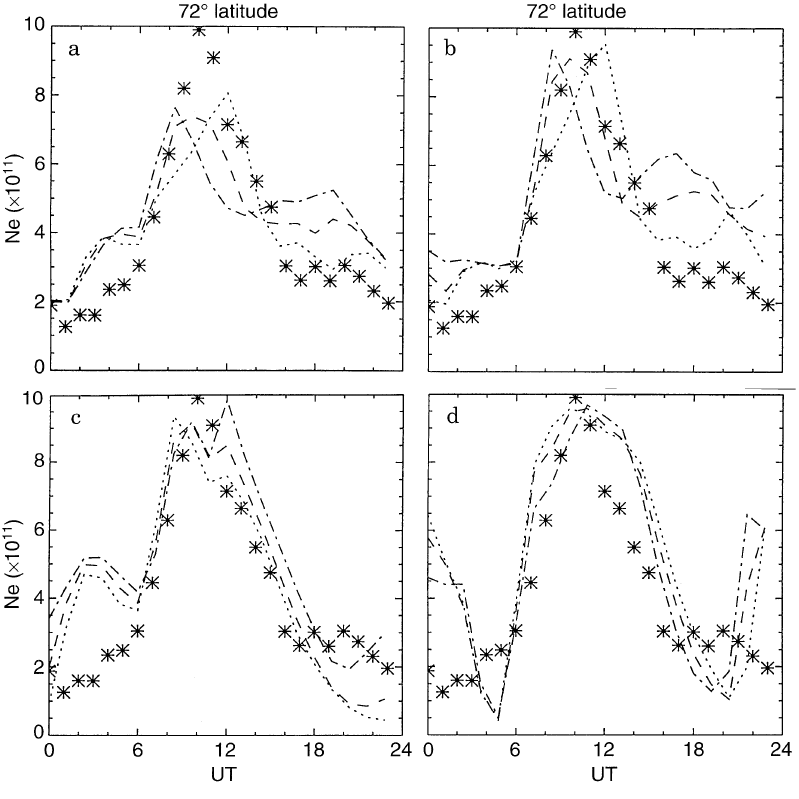
Fig. 9a (cid:177) d. Measured ( asterisks ) and modelled ( lines ) electron densities at 300 km and 72 ° N. a RUN-DEF, b RUN-1, c RUN-2, and d RUN-3. The dotted line is at the latitude of the data minus 2 ° , dashed line is at the same latitude as the data, and the dot - dash line is at the latitude of the data plus 2